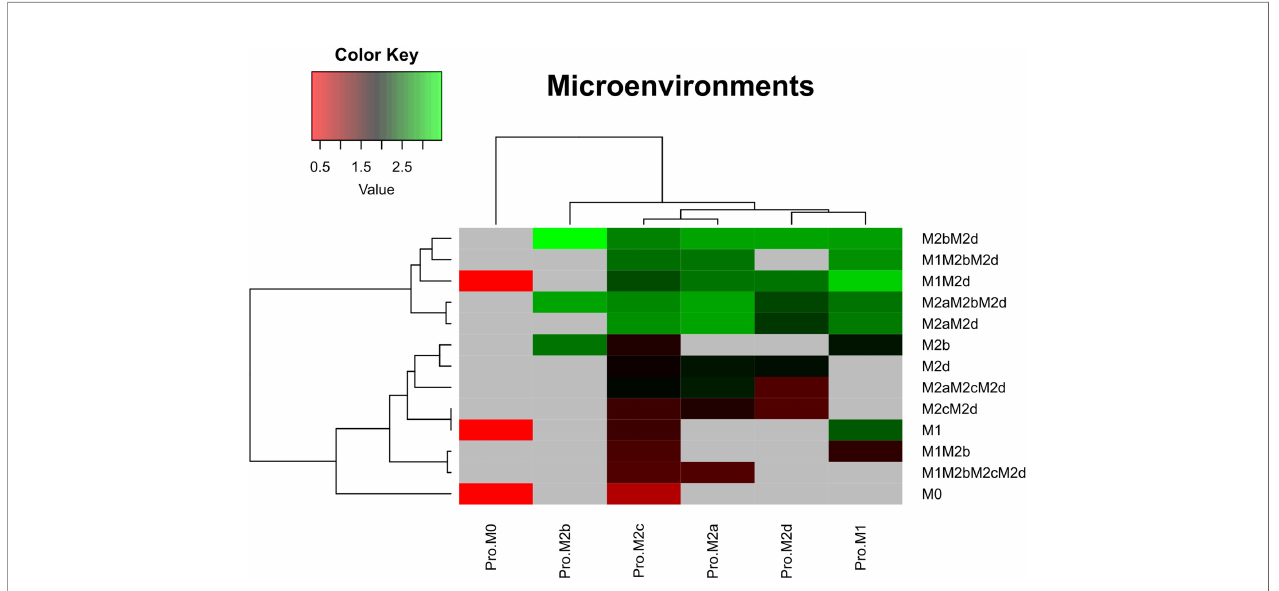
FIGURE 4 | Heat maps of the microenvironments of macrophage polarization. Microenvironments associated with the six phenotypes evaluated in this work. For these simulations we used the criteria of Table 2 . Once the attractors were obtained, we applied a logarithmic transformation on the size of the basin of attraction for each phenotype. Red stands for a low basin of attraction and green for a high basin of attraction. Pro means we modelled the polarization in a microenvironment adjuvant for each macrophage subtype. M0, monocytes.